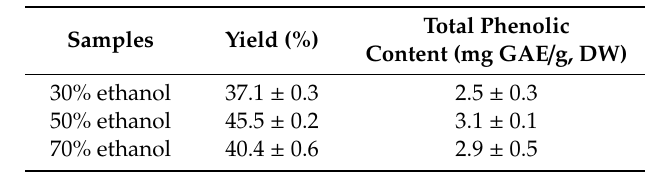
Table 4. Extract yield and total phenolic content of E. formosanus with di ff erent ethanol concentration